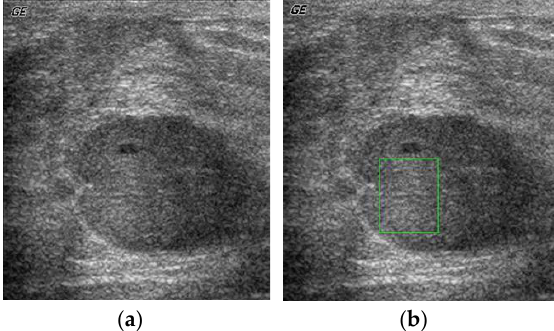
Figure 2. ( a ) General representation of the ultrasound breast cyst imagery, ( b ) marked and segregated ROI (region of interest) portions from this imagery.